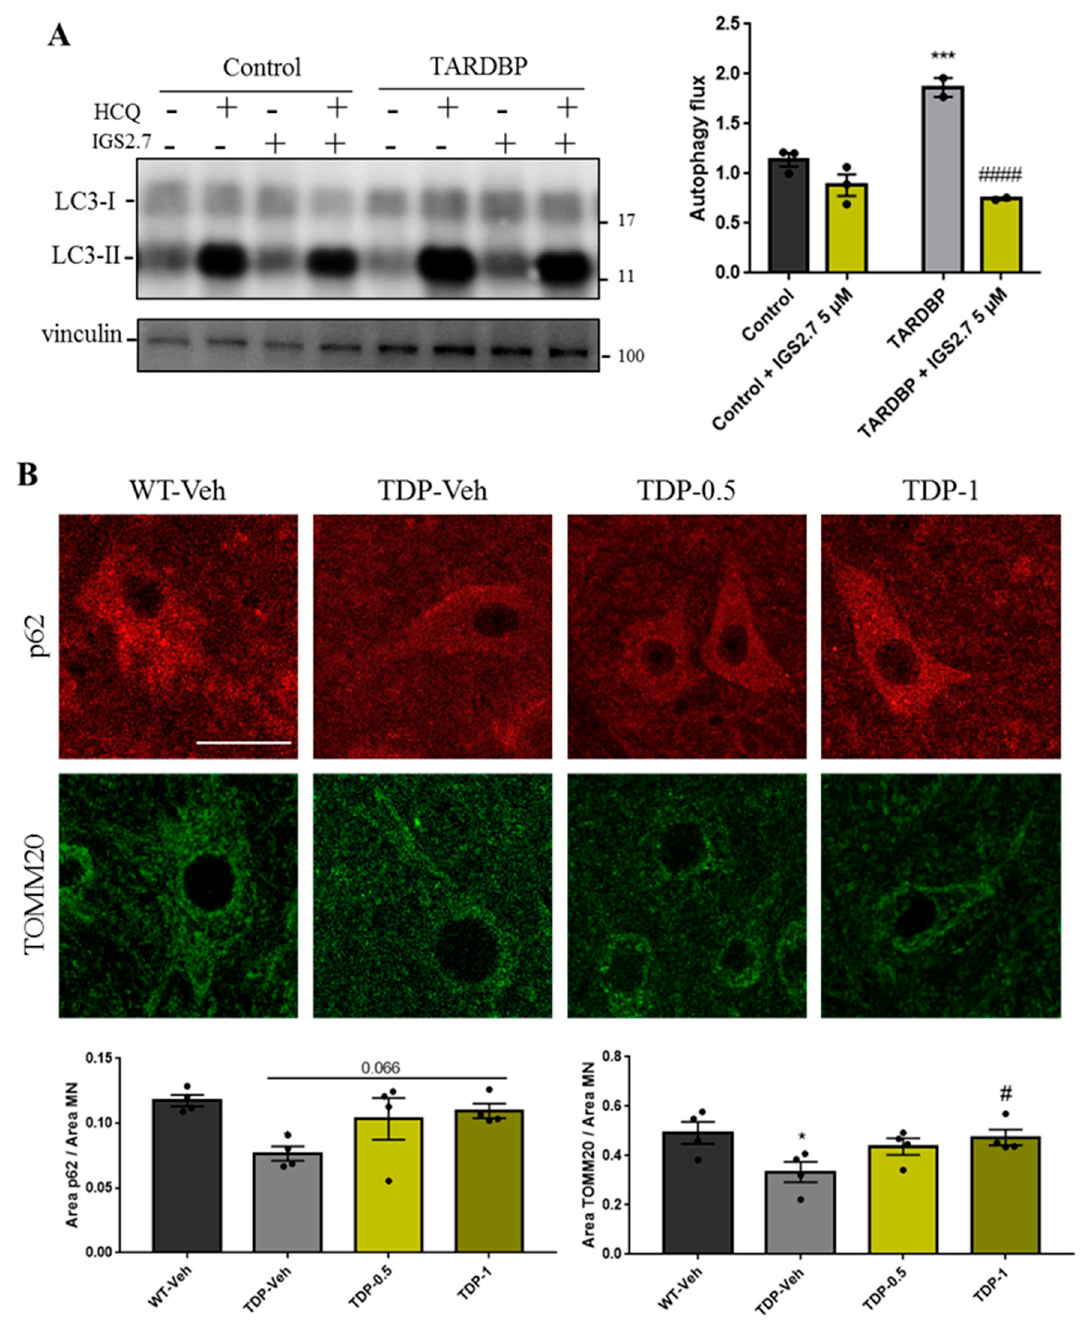
Figure 7. IGS2.7 restored the autophagy flux in cellular and animal TARDBP models of ALS. ( A ) Lymphoblasts were incubated in the presence and absence of 5 µM IGS2.7 for 24 h. Hydroxychloroquine (HCQ) was added during the last 3 h when indicated. Each point represents the mean of three independent experiments. Data represent the mean ± SEM of three controls and four TARDBP lymphoblastic cell lines (significance was determined by one-way ANOVA followed by Dunnett’s multiple comparisons test, where *** p < 0.001 vs. control and #### p < 0.001 vs. SOD1-ALS). ( B ) Histological samples of the anterior horn of the spinal cord of TDP-43 mice and wild-type controls. Tissues were immunostained for p62 and TOMM20 and quantified per MN. Data represent mean ± SEM of four different animals (significance was determined by one-way ANOVA followed by Dunnett’s multiple comparison test, where * p < 0.05 compared with WT and # p < 0.05 compared with TDP-Veh). Scale bar = 30 µm.